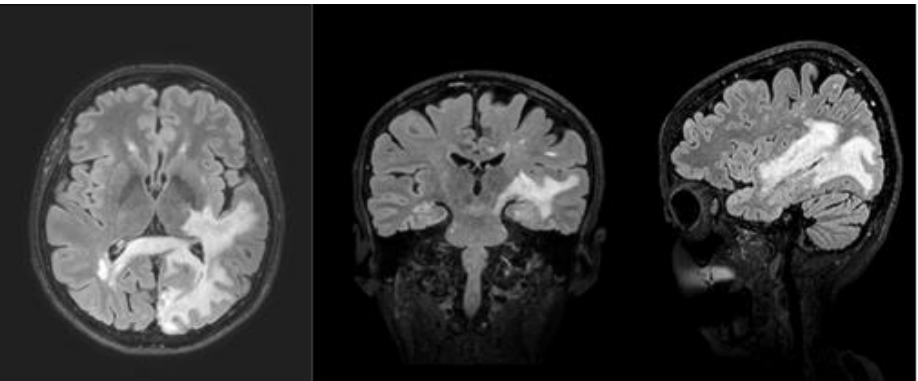
Figure 1. FLAIR3D showed massive area of altered signal intensity in the left occipital lobe and in the anterior ipsilateral temporal lobe, with initial involvement of the ipsilateral posterior nucleus-capsular region.